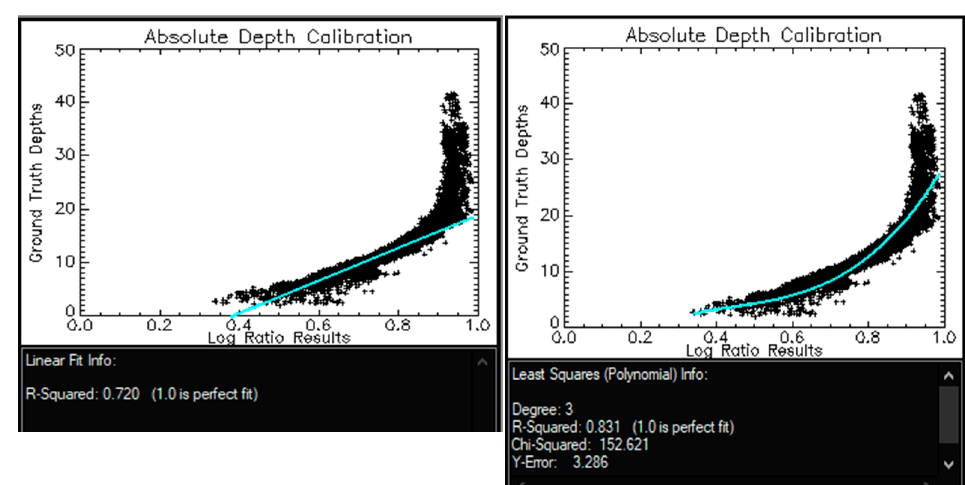
Figure A13. From 27 October 2016.